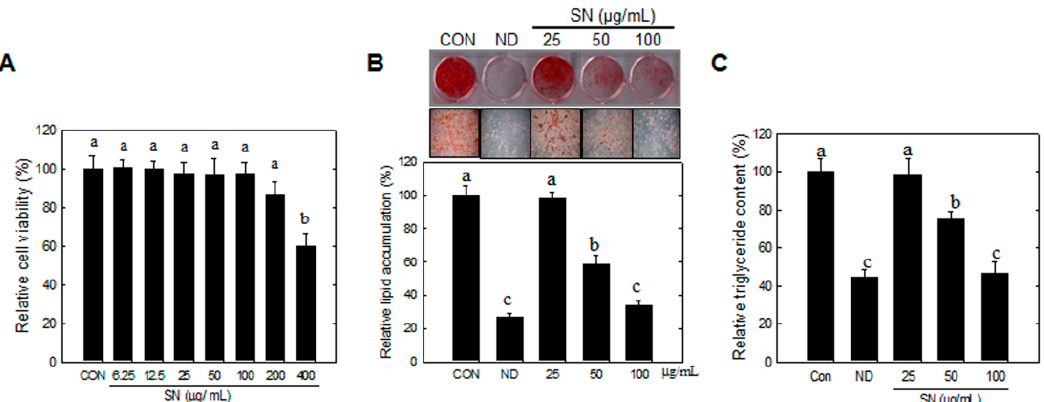
Figure 1. Effects of SN on lipid and triglyceride in adipocyte. Differentiation was induced by incubation with a hormone cocktail in the presence or absence of SN for eight days. ( A ) Cytotoxicity of SN treatment ( B ) After eight days, the cells were stained with Oil red O, which was subsequently eluted in isopropanol and its optical density at 490 nm was measured; ( C ) Triglyceride (TG) accumulation was determined using a TG assay kit (Zen Bio, Inc., Research Triangle Park, NC, USA). CON: control, SN: seapolynol, ND: non-differentiated 3T3-L1. Data are presented as means ± SD from three replicates. Means not designated by a common superscript are significantly different ( p < 0.05).